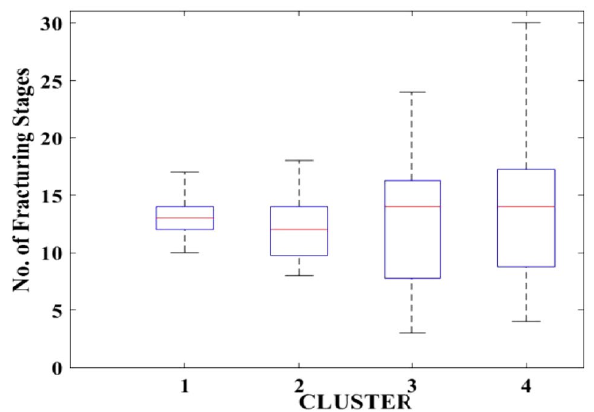
Figure 6. No. of fracturing stages.